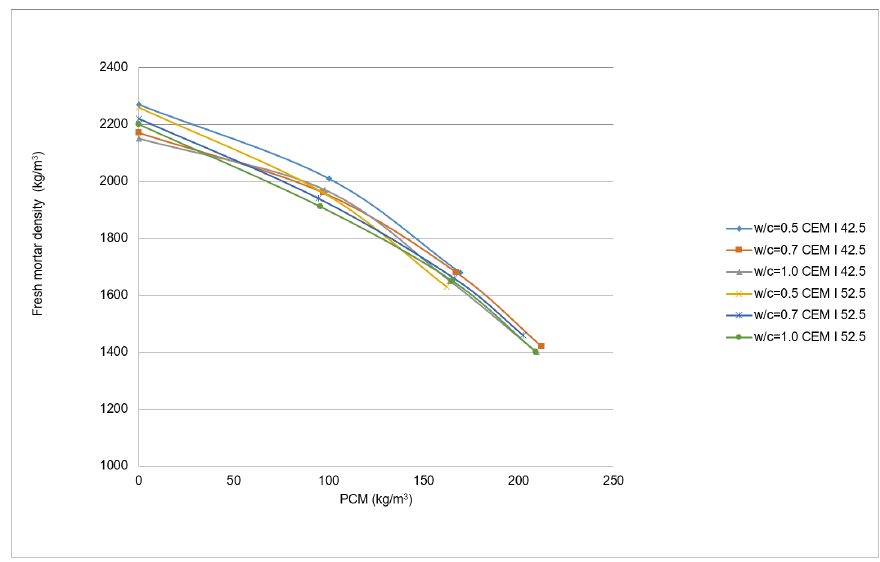
Figure 8. Fresh mortars density variation.